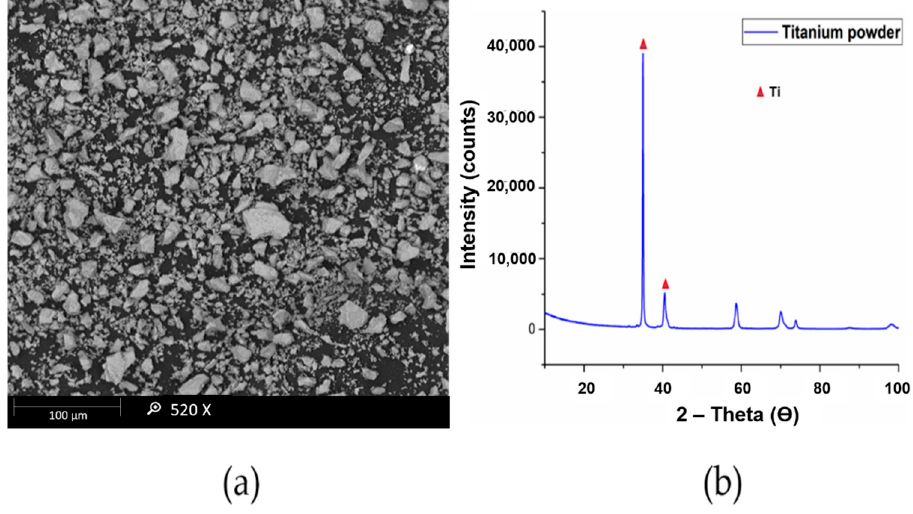
Figure 2. ( a ) SEM ( b ) XRD analysis of titanium powder.